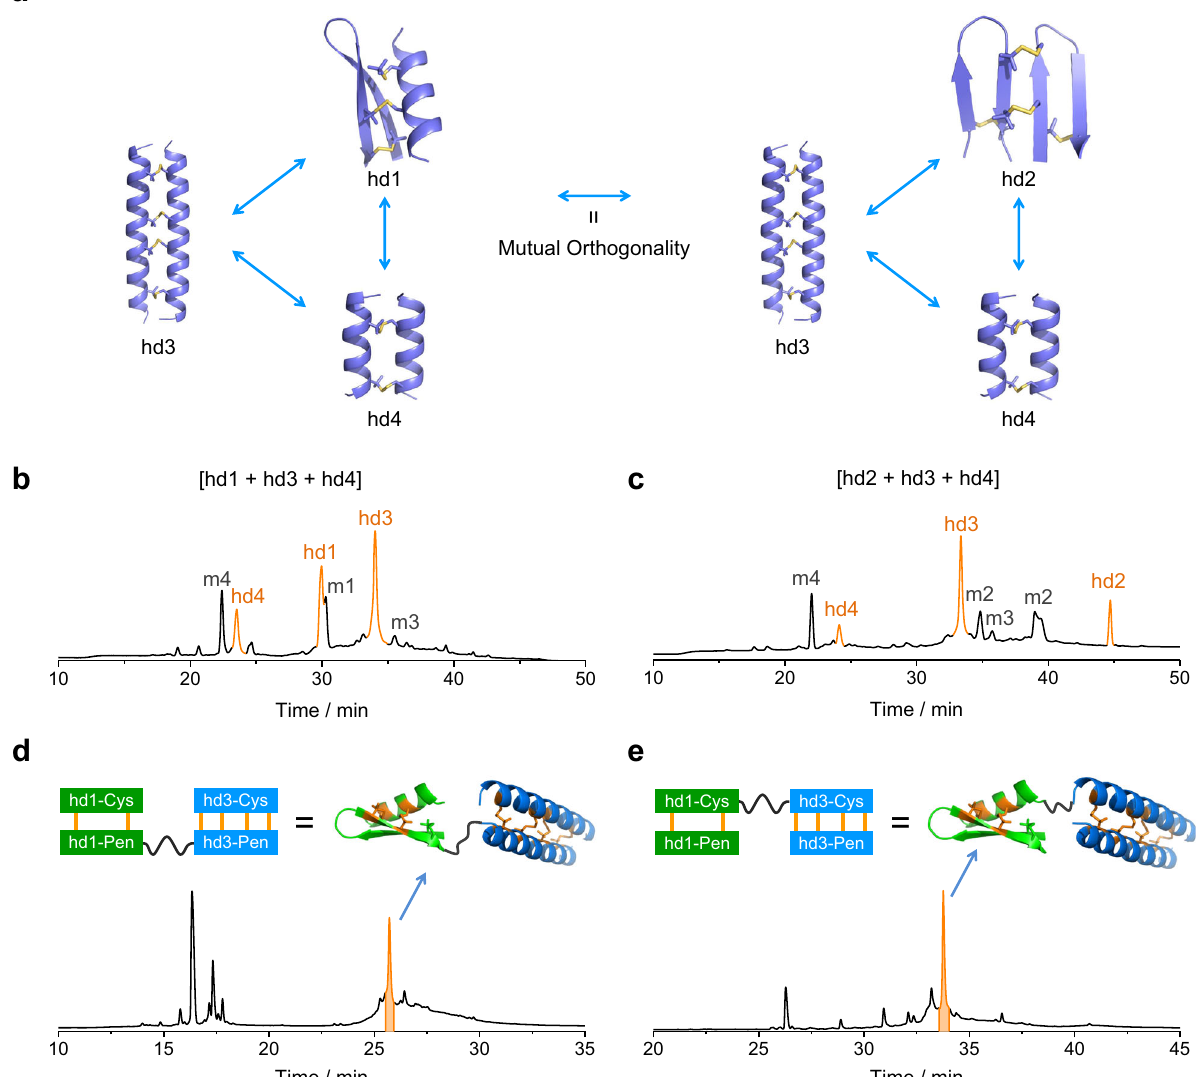
Fig. 4 Orthogonality of peptide heterodimerizations. a Excellent orthogonality was observed between each two heterodimers except for the orthogonality between hd1 and hd2 (Supplementary Figs. 27 ‒ 32). b and c Excellent orthogonality was observed in the formation of three heterodimers ( b : hd1/hd3/hd4; c : hd2/hd3/hd4). m1 ‒ m4 denote the oxidized products of the excess Pen-bearing monomers of hd1 ‒ hd4, respectively. d and e Oxidation-induced dimerization leading to formation of the tandem heterodimers: hd1 and hd3 were connected with a fl exible linker containing a tobacco etch virus (TEV) protease cleavage site (ENLYFQG). Source data are provided as a Source Data fi orthogonal peptide heterodimers (Fig. 5b). SUMO with a hd3 monomer tag and Neo-2/15 or MLK3-SH3 with a hd1 monomer tag were mixed in the reaction buffer for the orthogonal labeling.